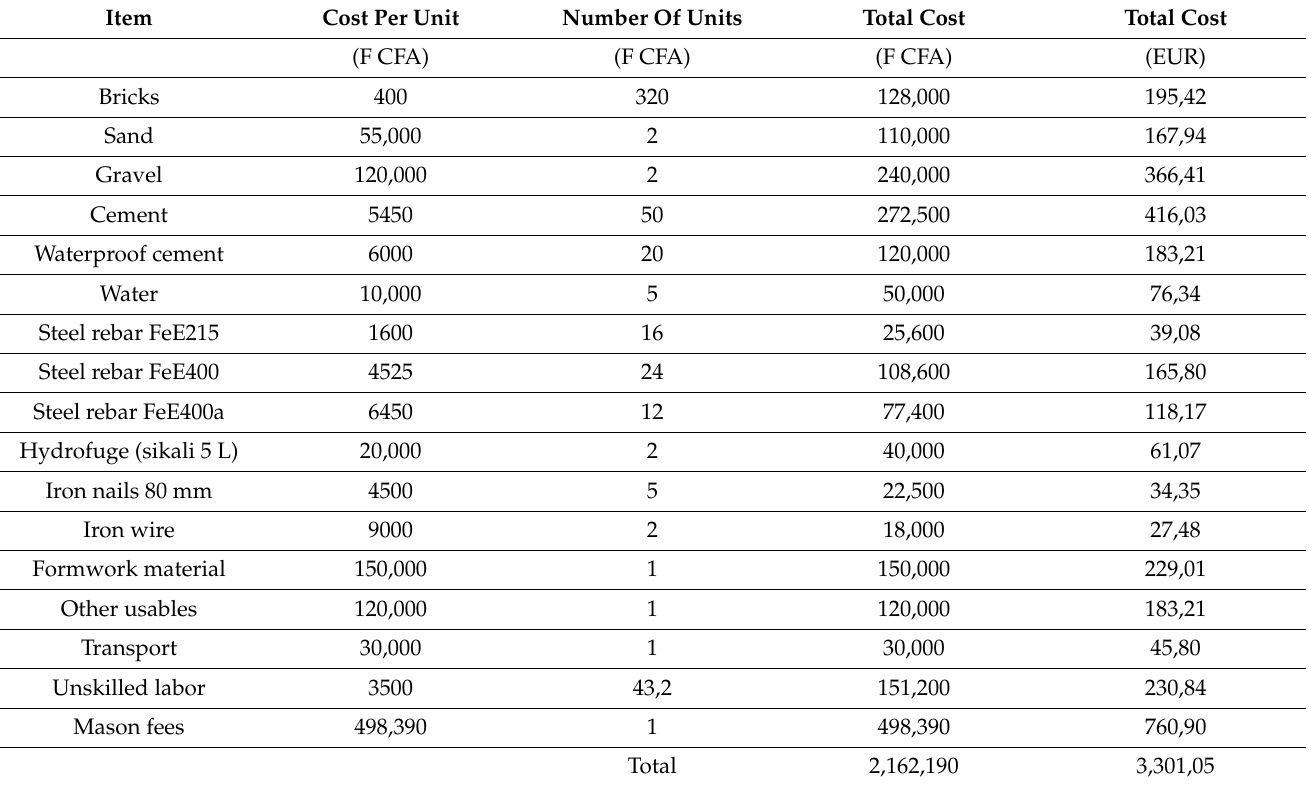
Table 3. Estimation of costs for a buried concrete water cistern with 30,000 L (30 m 3 )